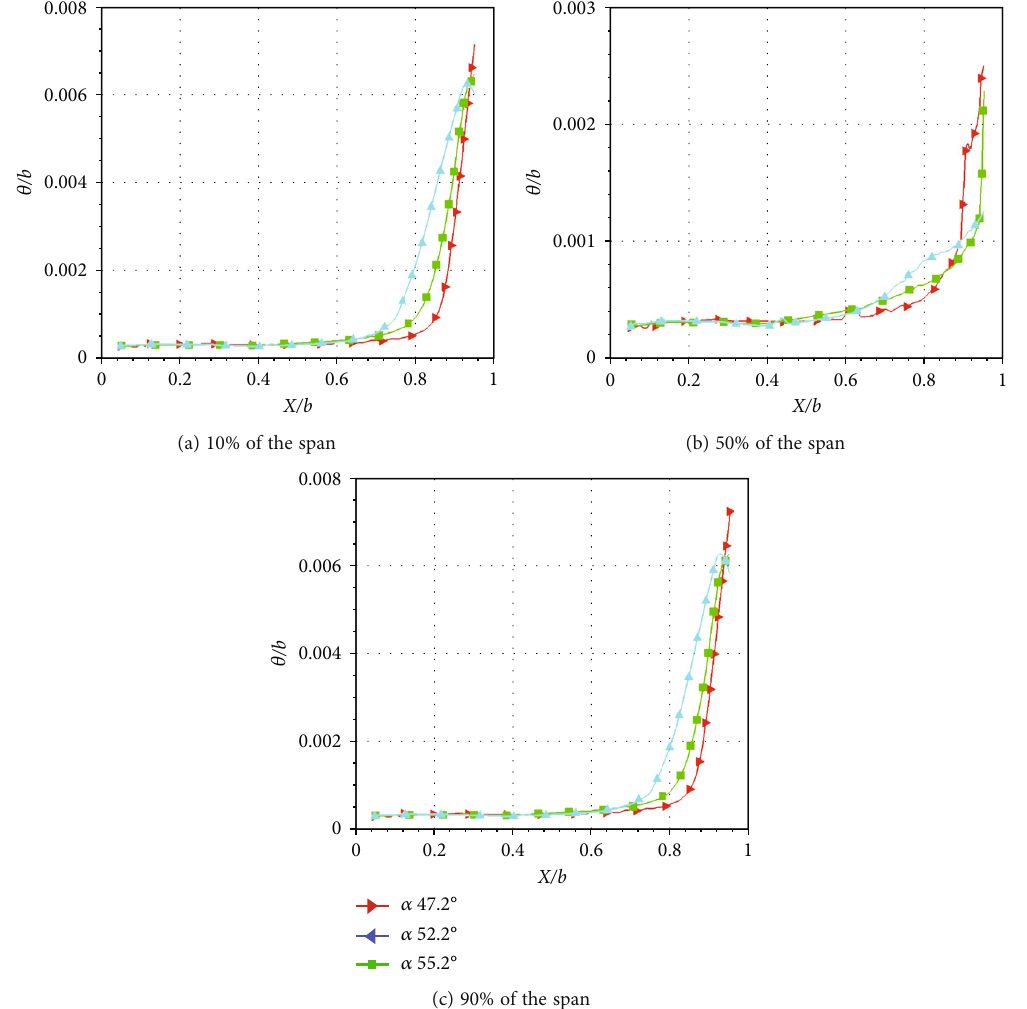
Figure 9: Comparison of boundary layer momentum thickness for di ff erent stagger